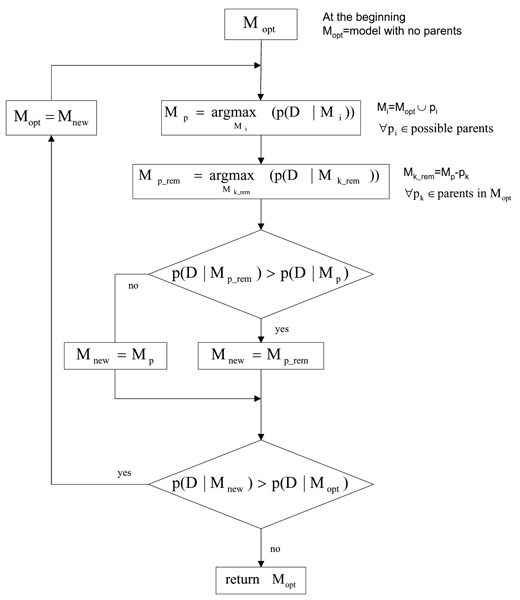
Search strategy. Schematic illustration of the strategy used to look for the parent set of each variable (see Methods).